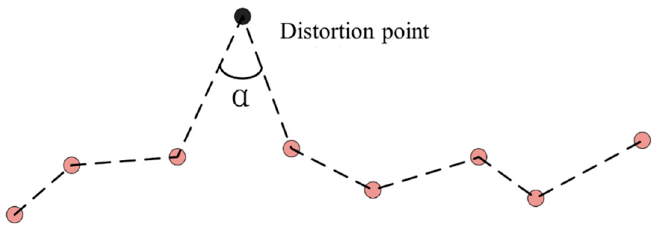
Figure 6. Distortion points on scanning line.